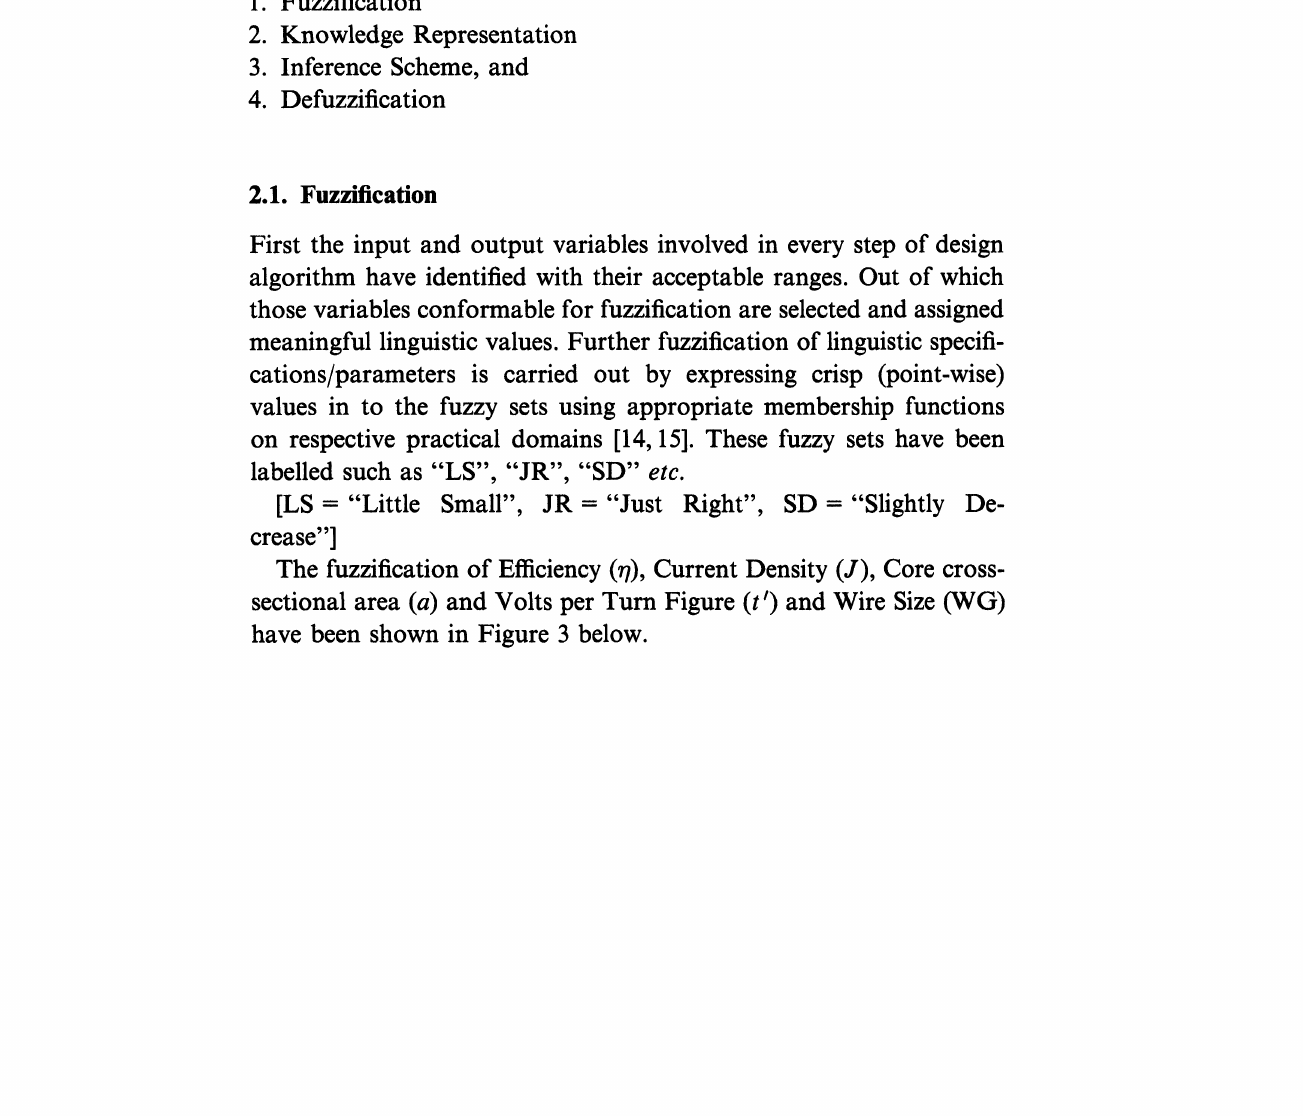
FIGURE 2 General schematics of